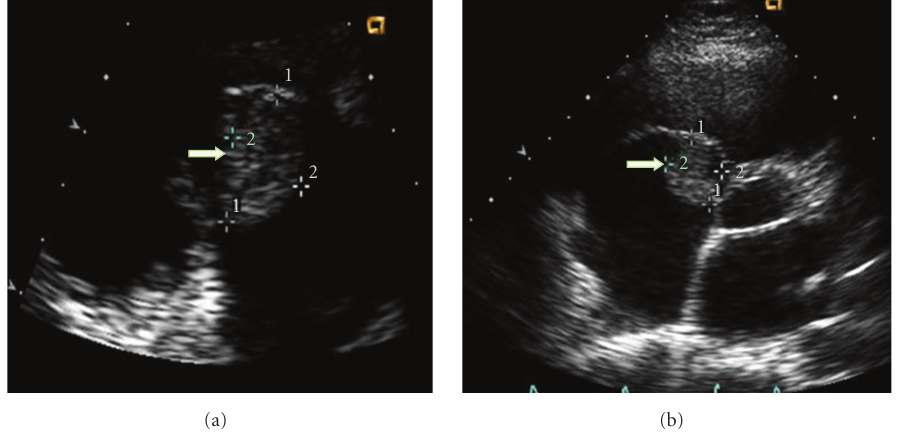
Figure 1: This is a transthoracic echocardiogram. White arrows point to the 2.6 × 1.7 cm pedunculated